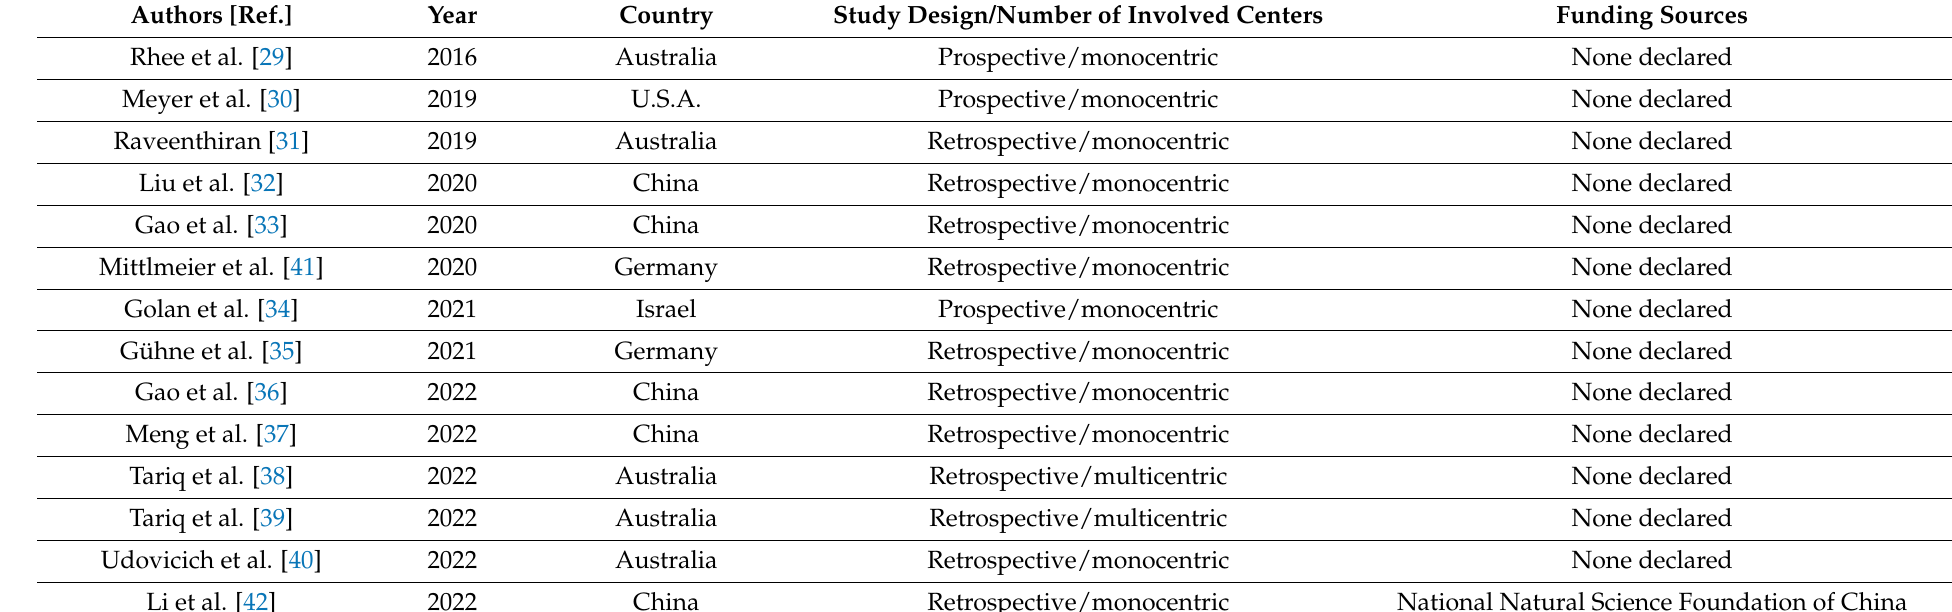
Table 1. General study information.